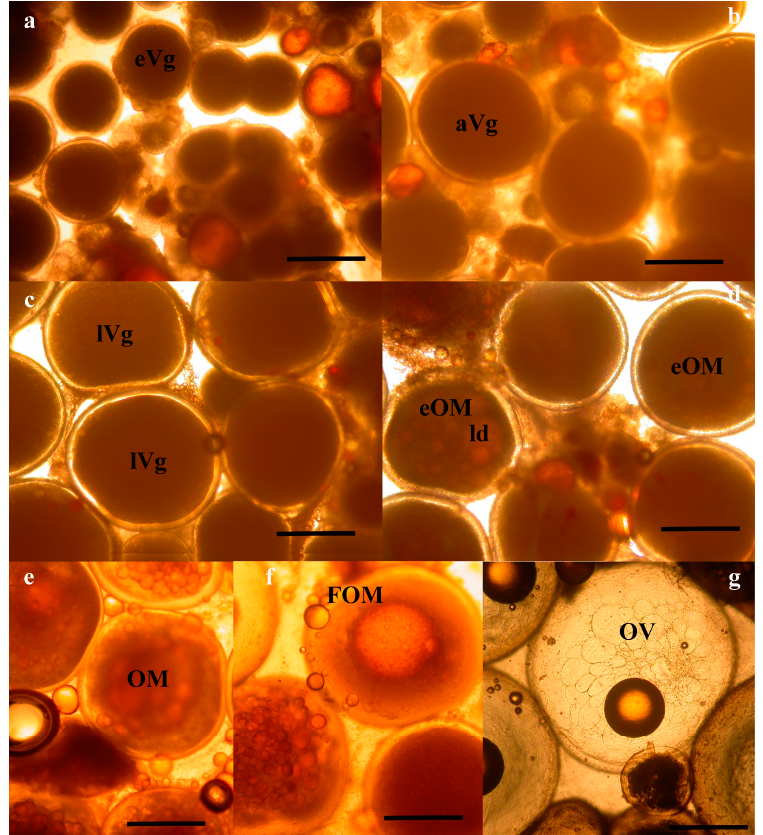
Figure 1. Photomicrographs of wet mount wreckfish biopsies, showing oocytes at successive stages of development: ( a ) early vitellogenesis (eVg); ( b ) advanced vitellogenesis (aVg); ( c ) late vitellogenesis (lVg); ( d ) early ovarian maturation (eOM) with lipid droplet (ld) coalescence; ( e ) advanced oocyte maturation (OM); ( f ) final oocyte maturation (FOM); and ( g ) ovulation (OV). The bar is 500 μ m.